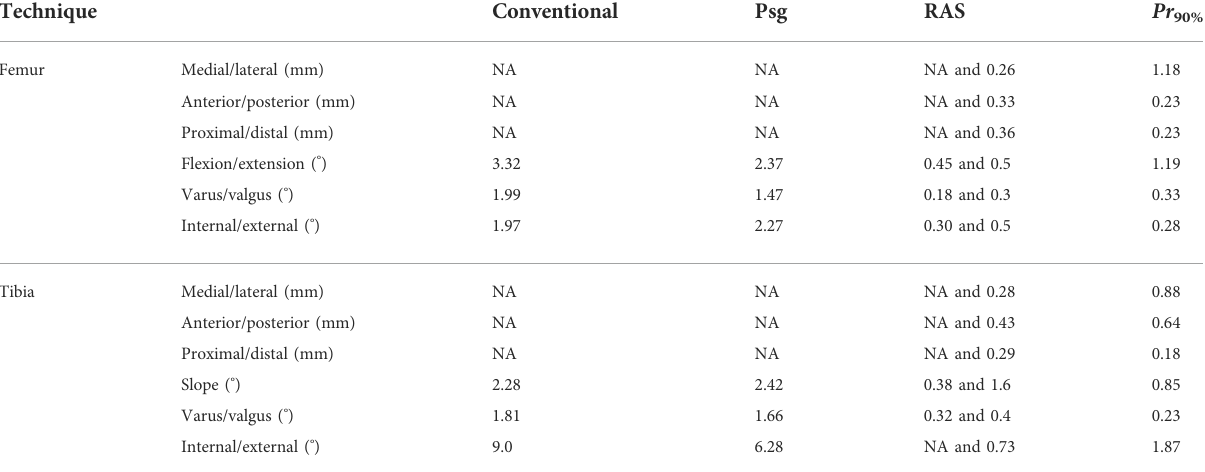
TABLE 1 Surgical precision — according to the literature — is reachable with conventional surgery (De Vloo et al., 2017), patient-speci fi c guides (De Vloo et al., 2017), RAS (MAKO (Hampp et al., 2019) and TSolution One (Cosendey et al., 2021)), and Pr 90% (Bartsoen et al., 2021). It is to be noted that Hampp et al. (2019) did not report on all DOFs; the non-reported DOFs are indicated with “ NA. ”